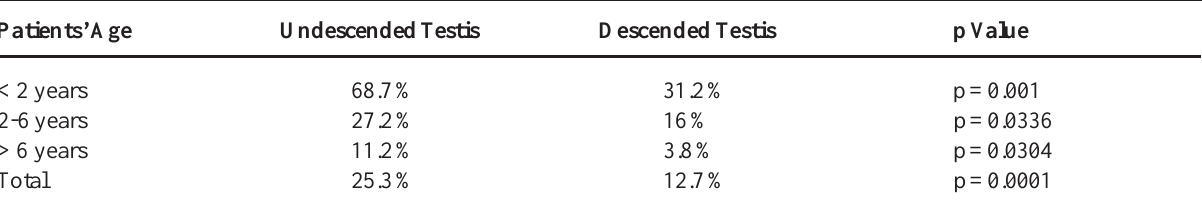
Table 1 – Patency of the processus vaginalis in descended and undescended testis related with age groups, N of PPV / N of testes